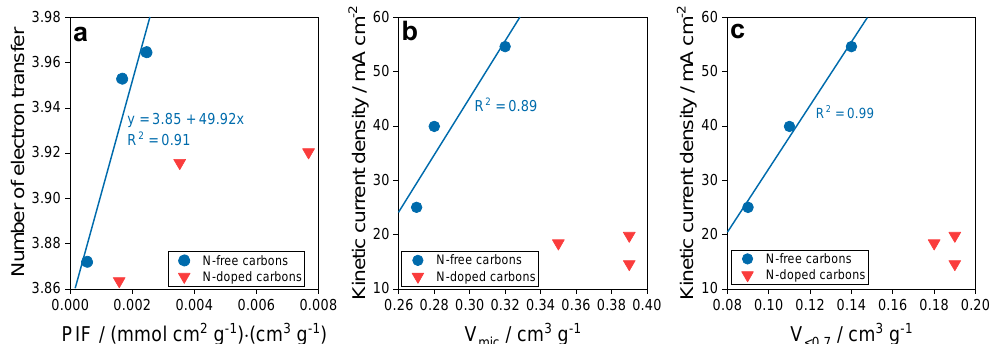
Figure 10. ( a ) Dependence of the number of electron transfer on PIF, and dependence of the kinetic current density on ( b ) volume of micropores and ( c ) volume of ultramicropores. Reprinted with permission from Reference [57], Copyright 2019, The Royal Society of Chemistry.